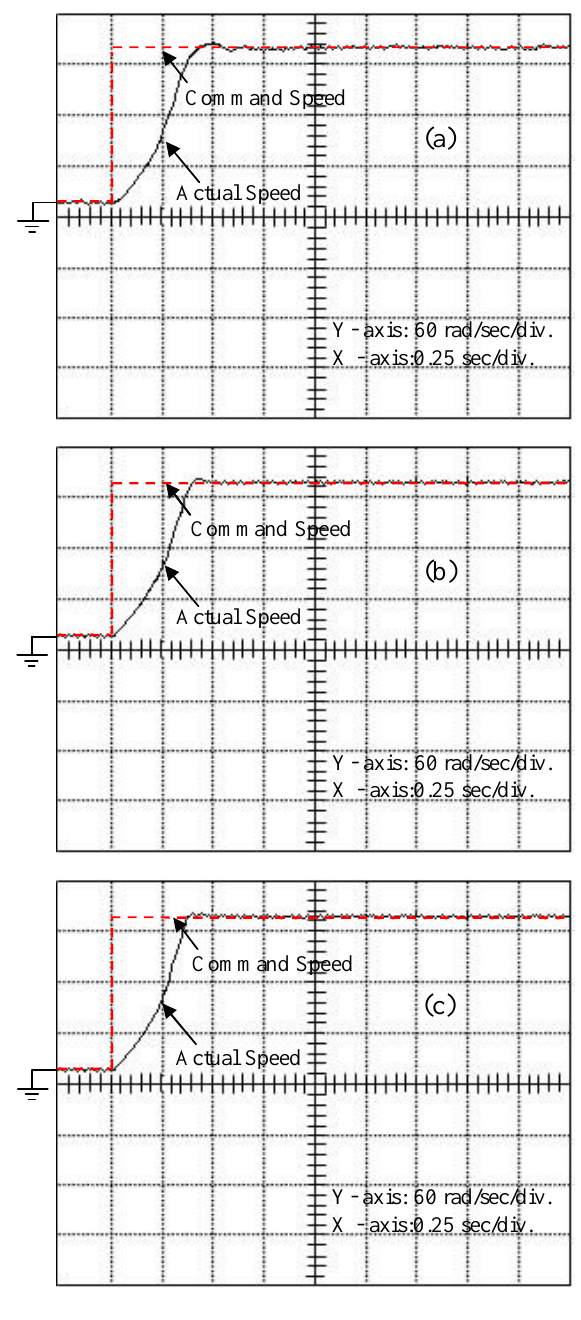
Fig. 14. Experimental results for starting performance of (a) PI controller (b) Fuzzy PI controller and (c) the proposed Wavelet – fuzzy